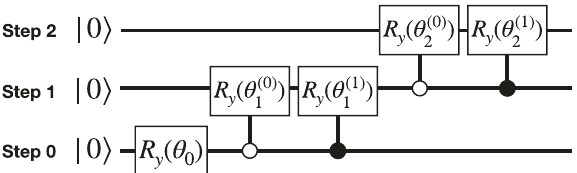
Fig. 3 Quantum circuit to prepare the index system for simulating a path-dependent DSP. The fi gure depicts an example of the fi rst- order Markov chain of two steps each consisting of two realizations.